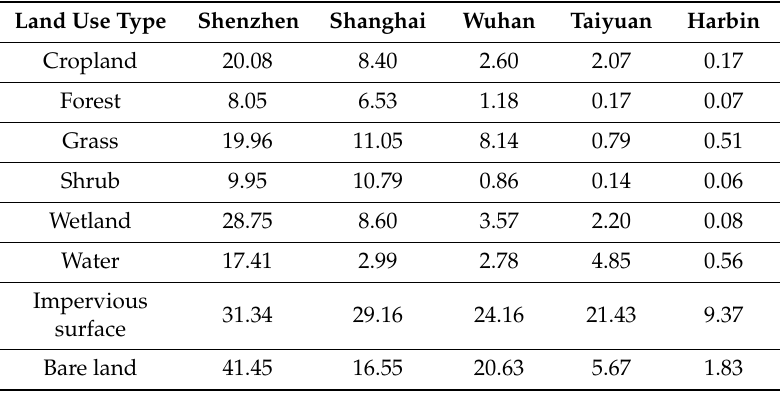
Table 5. Estimated NLIs of the five provincial capital cities in